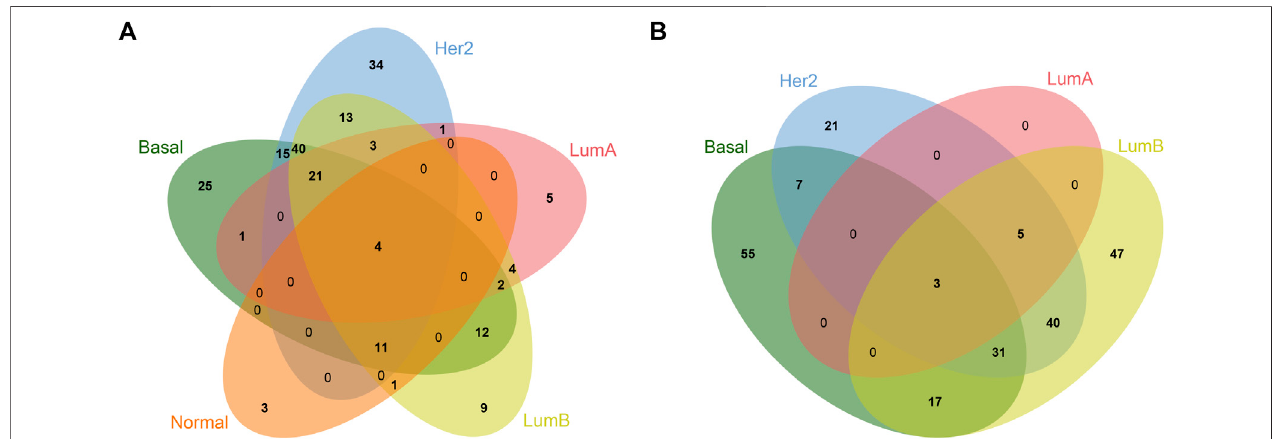
FIGURE 2 | Venn diagram of common and speci fi c DEGs in different breast cancer subtypes. (A) Upregulated DEGs; (B) Downregulated